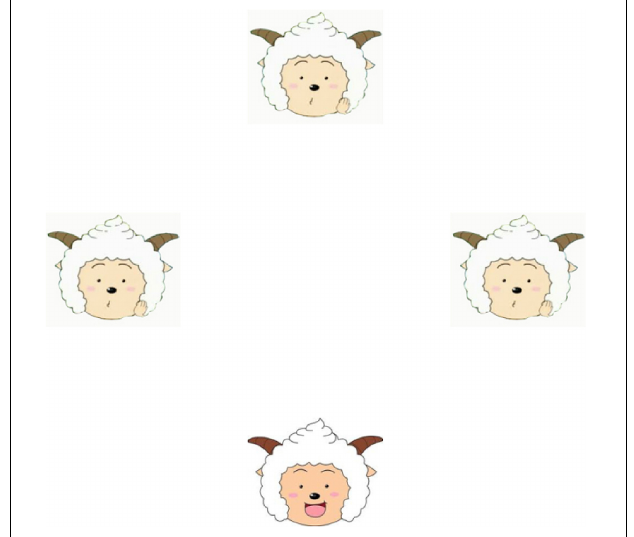
FIGURE 3 | Stimuli in a sample training trial in Experiment 1, with the happy target at the